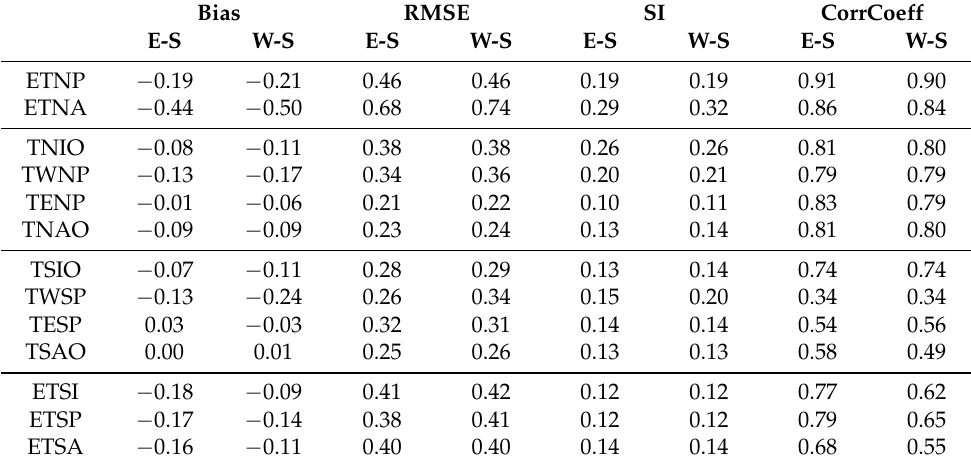
Table 3. Error measures (Bias, RMSE, SI, CorrCoeff) between (a) (E)RA5 and (S)atellite, (b) (W)W3 and (S)atellite for the 13 subregions (significant wave height). Bias